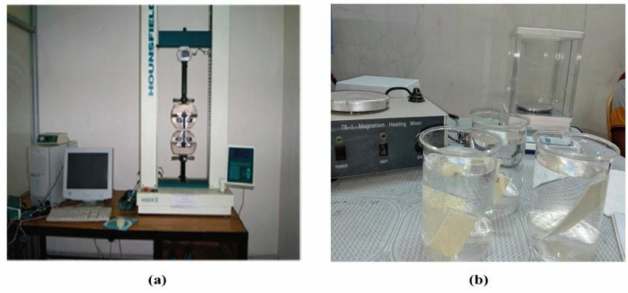
Figure 2. ( a ) Universal testing machine (UTM) and ( b ) water uptake (%)